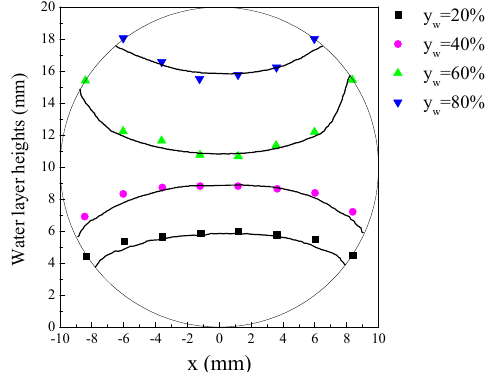
Figure 8. Comparison of static interface heights measured by the CPAP and PLIF. The solid lines represent the interface heights derived from the PLIF visualizations.